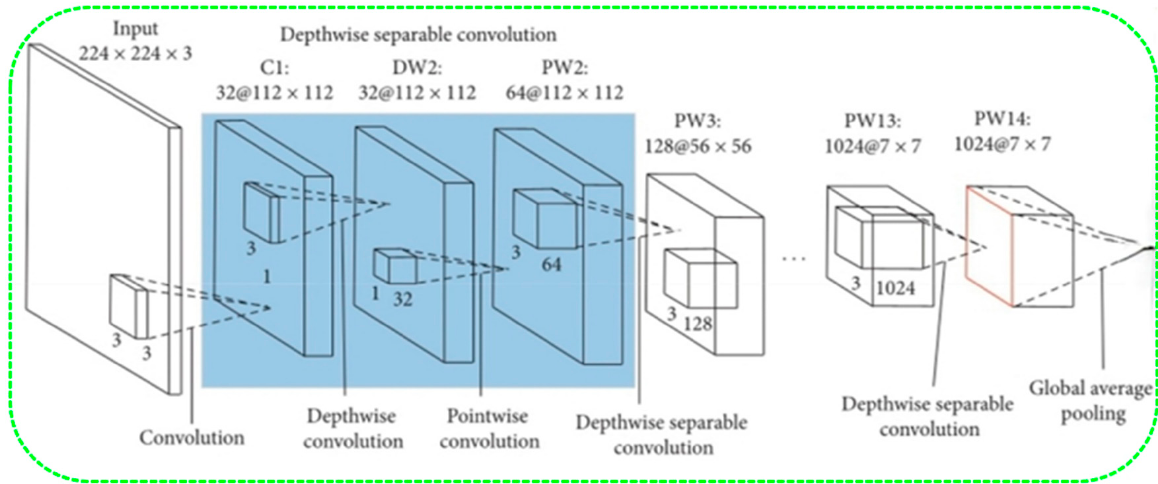
Figure 2. MobileNet building block.